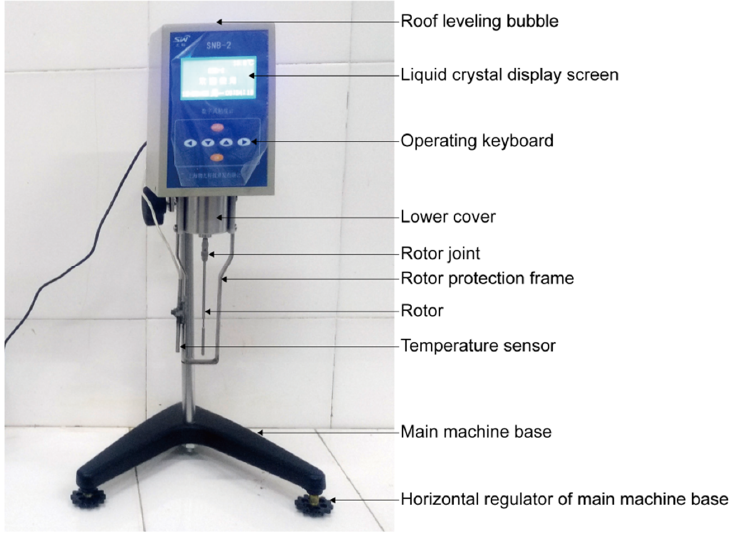
Figure 3. The SNB-2 microcomputer digital display viscometer.